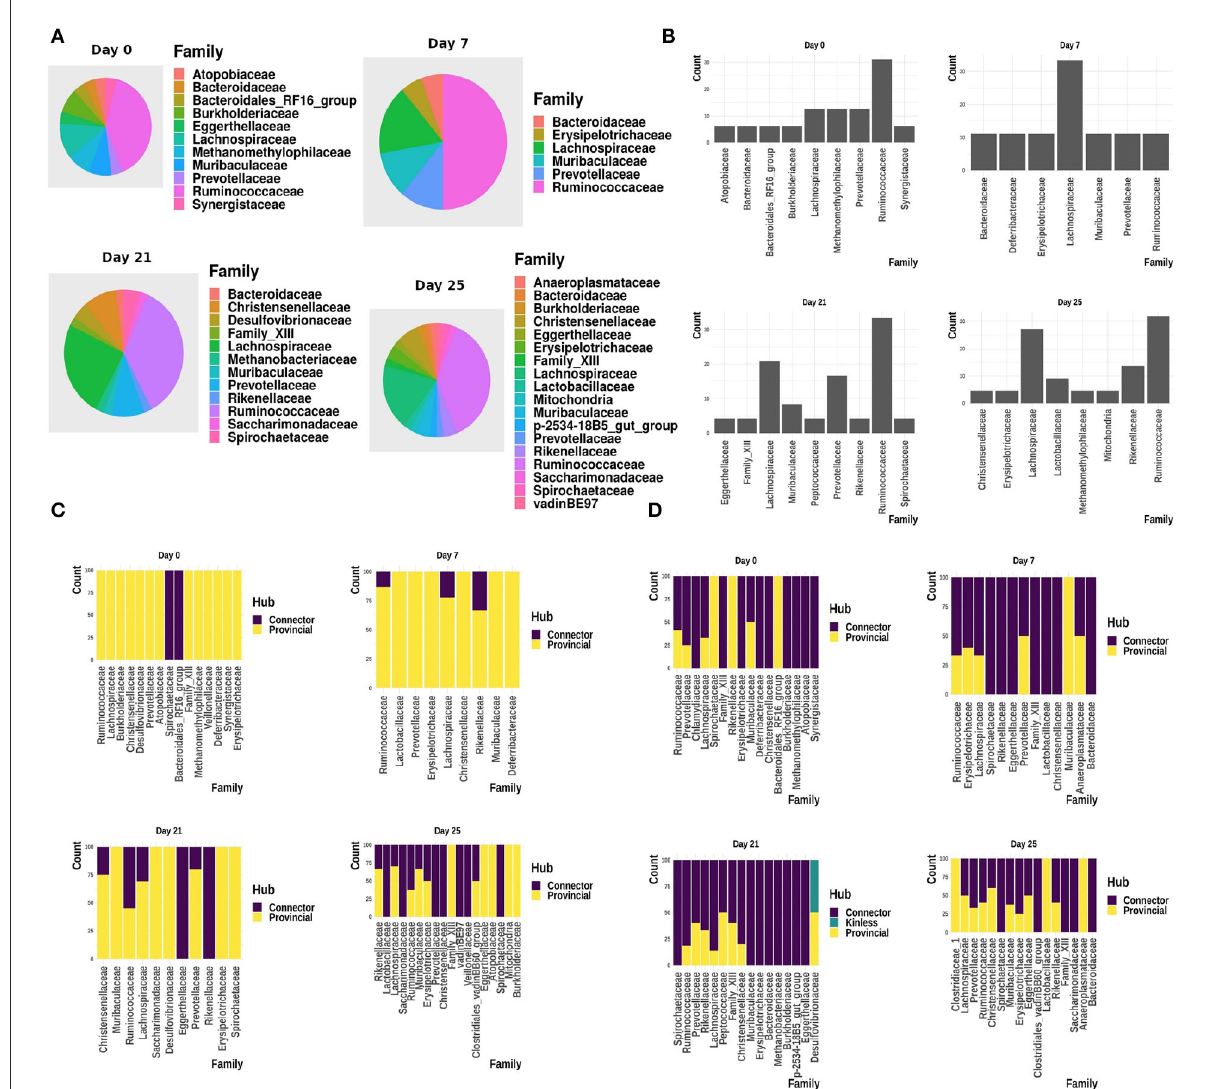
FIGURE10 (A) Relative proportion of driver ASVs assigned to the corresponding microbiome families at each of the time-points. (B) Relative proportion of ASVs belonging to the infected-core-hub communities, assigned to the corresponding microbiome families at each of the time-points. (C) Relative proportion of ASVs identified as hubs in healthy co-abundance networks. (D) Relative proportion of ASVs identified as hubs in infected co-abundance